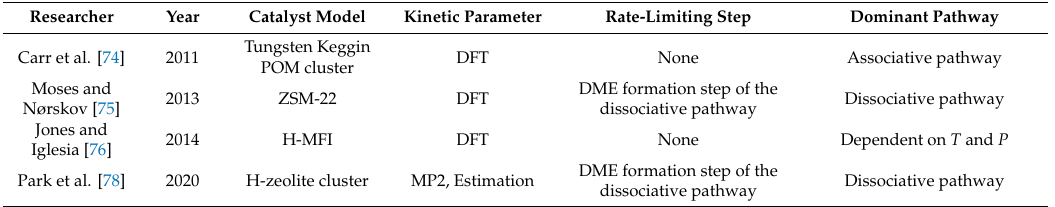
Table 4. Previous microkinetic studies on DME